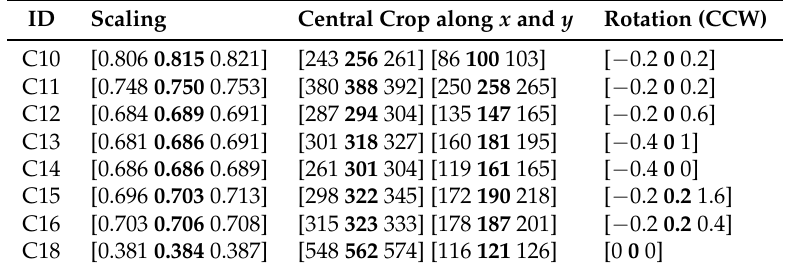
Table 3. Rescaling and cropping parameters that link image and video SPNs for the considered devices using in-camera digital stabilization. The values are computed on the first 10 frames of the available video reference; min, median (bold), and max values are